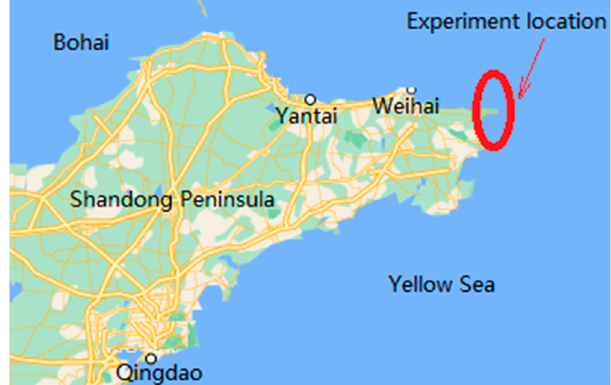
Figure 3. Chengshantou sea trial area.